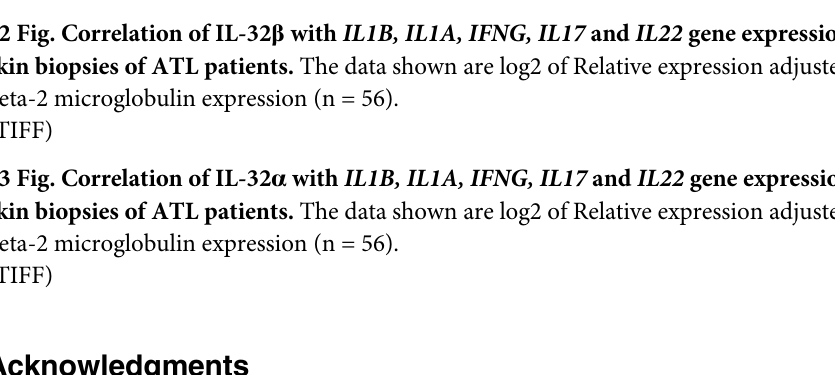
S2 Fig. Correlation of IL-32 β with IL1B, IL1A, IFNG, IL17 and IL22 gene expression in skin biopsies of ATL patients. The data shown are log2 of Relative expression adjusted for beta-2 microglobulin expression (n = 56). (TIFF) S3 Fig. Correlation of IL-32 α with IL1B, IL1A, IFNG, IL17 and IL22 gene expression in skin biopsies of ATL patients. The data shown are log2 of Relative expression adjusted for beta-2 microglobulin expression (n = 56).